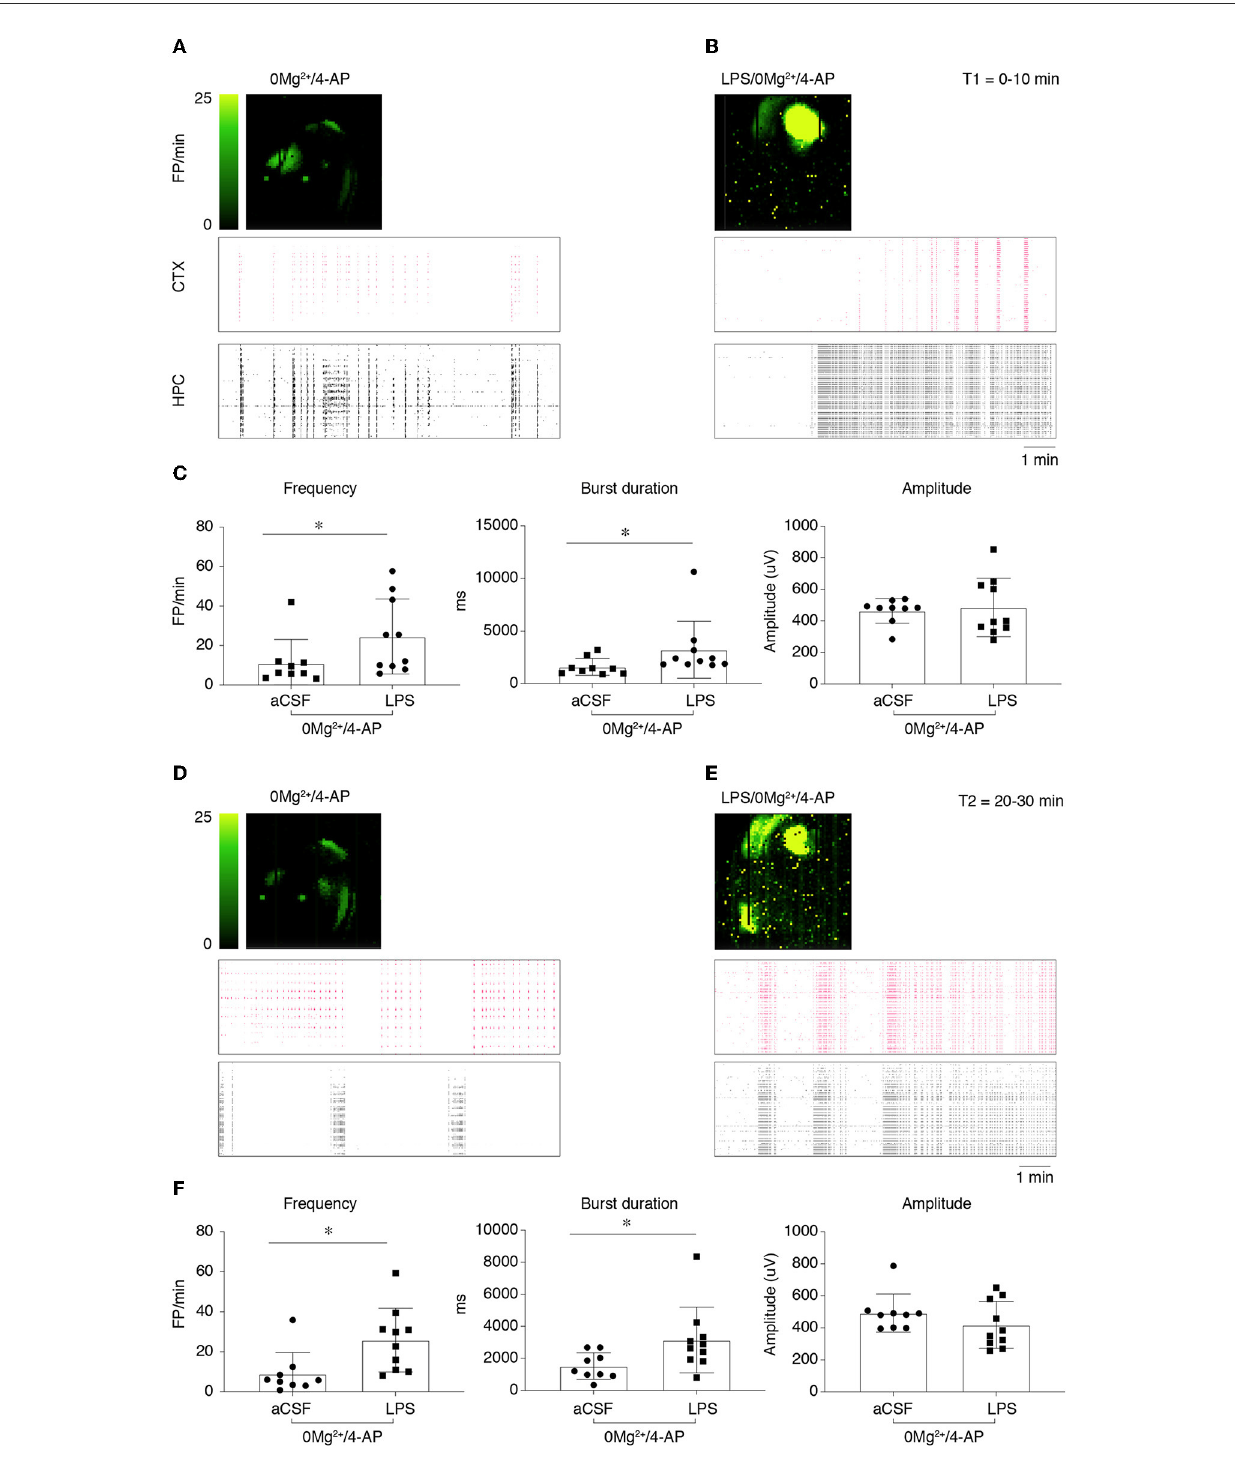
FIGURE2 Lipopolysaccharide effect on epileptiform activity in hippocampus/temporal cortex slices. (A, B) Depict representative activity maps ( first row ; higher field potential, FP, frequency corresponds to lighter green color) and raster plots ( second and third rows ) of epileptiform activity recorded in the temporal cortex (CTX) or hippocampus (HPC) during 0 Mg 2 + /100 µ M 4-AP perfusion alone (A) or in slices pre-incubated with LPS [ (B) ; 10 µ g/ml LPS for 30min, followed by 5min washout], then exposed to 0 Mg 2 + /100 µ M 4-AP for 40min. (C) Reports quantification of epileptiform activity (FP frequency, burst duration and amplitude) during T1 (0–10min from the start of 0 Mg 2 + /4-AP perfusion) reckoned in the area of higher activity (as shown by activity map/raster plot) in each slice. (D, E) Depict representative activity maps and raster plots during T2 (20–30min from the start of 0 Mg 2 + /4-AP perfusion). (F) Reports quantification of epileptiform activity during T2 reckoned in the area of higher activity in each slice. Data are presented as mean ± SEM and single values (0 Mg 2 + + 4-AP, n = 9 slices; LPS + 0 Mg 2 + + 4AP, n = 10 slices). * p < 0.05 vs. 0 Mg 2 + /4AP by Mann–Whitney